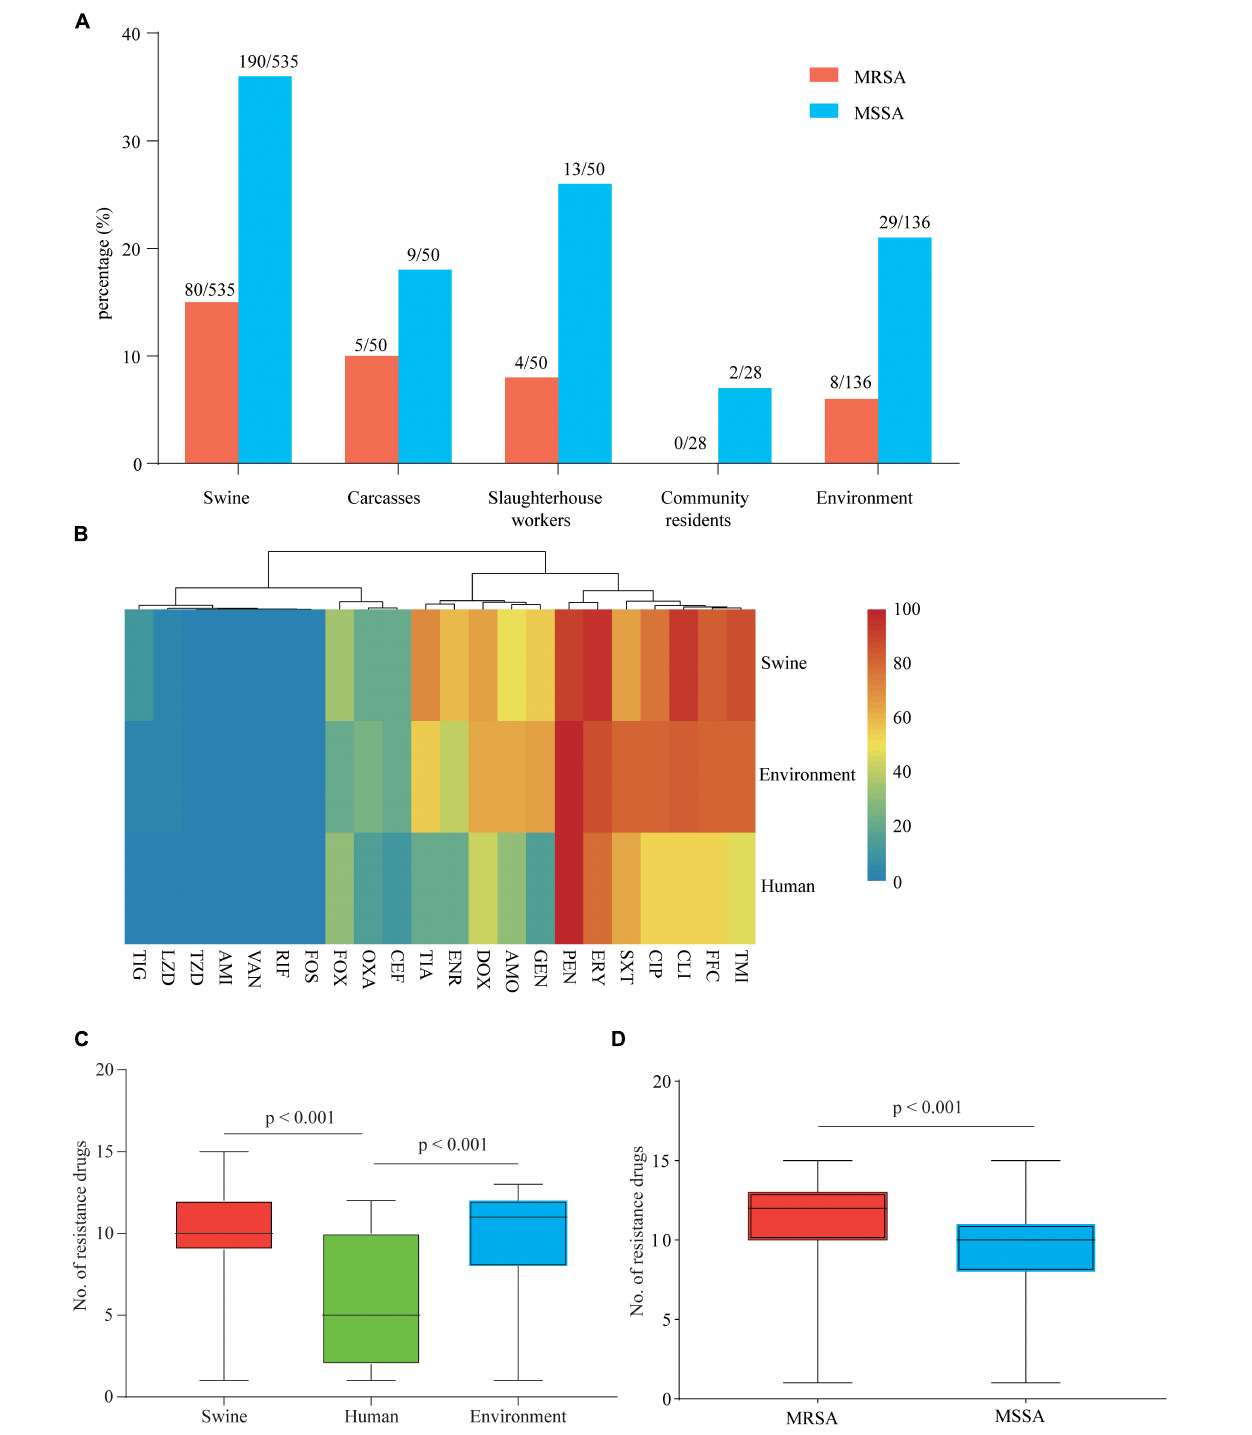
FIGURE 1 | Prevalence and drug resistance of isolates recovered from samples from various origins. (A) Prevalence of methicillin-susceptible Staphylococcus aureus (MSSA) and methicillin-resistant S. aureus (MRSA) in samples from various origins along and around a slaughterhouse in Guangzhou, China. (B) Each cell in the heat map indicates the percentage of strains with resistance to a particular drug. (C) The bar graph indicates the total number of drugs with resistance within each swine, human, and environment-associated isolate. (D) The bar graph indicates the total number of drugs with resistance within each MSSA and MRSA isolate. The numbers of swine, human, and environment-associated strains were 284, 19, and 37, respectively. The numbers of MSSA and MRSA isolates were 243 and 97,